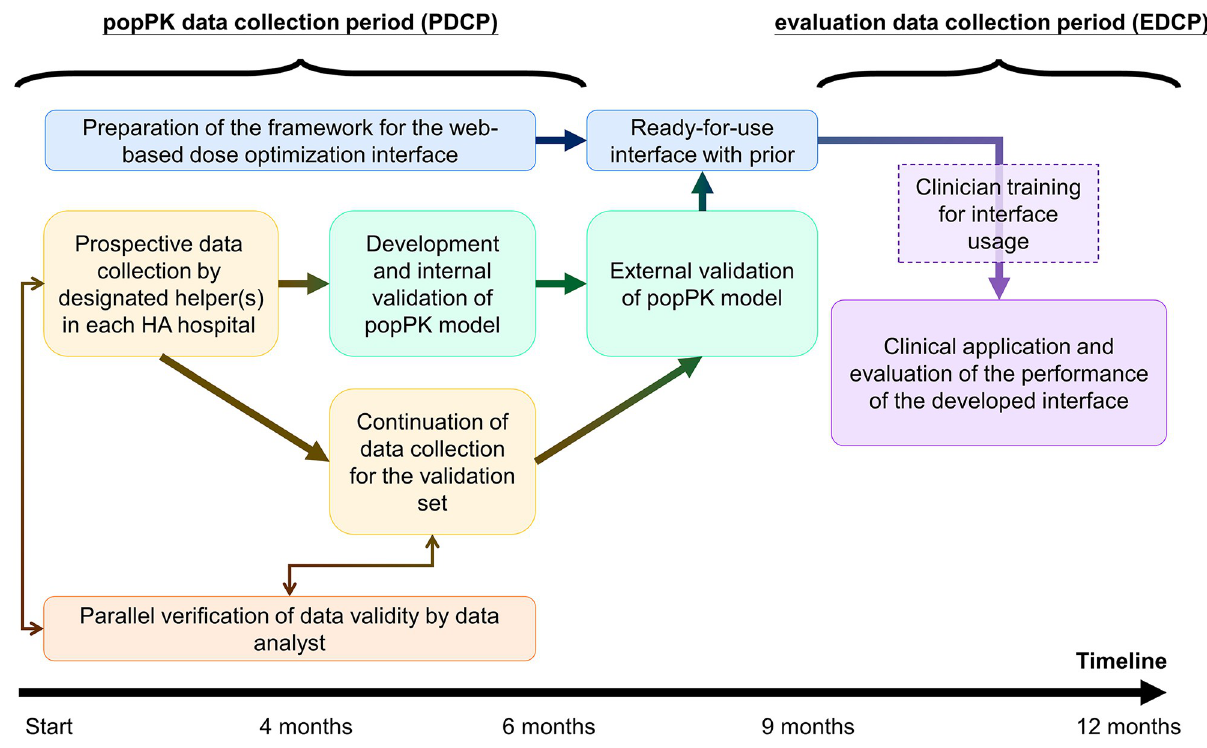
Fig 2. The study timeline. popPK: population pharmacokinetic. HA: Hospital Authority.